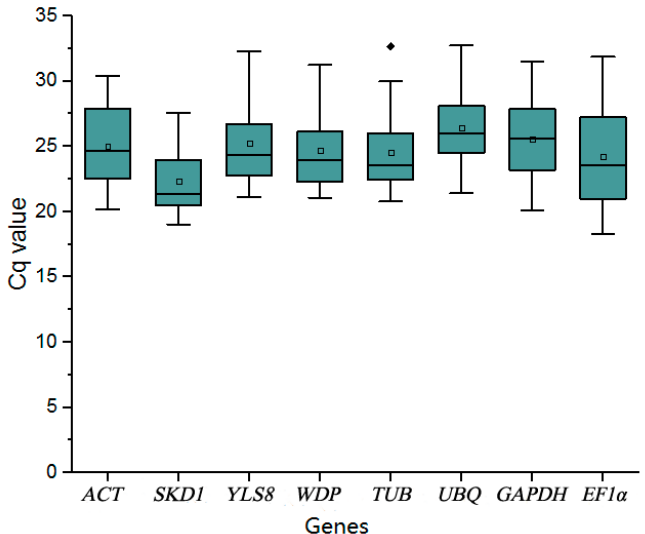
Figure 6. RT-qPCR Cq values of the candidate reference genes in pear leaves. Candidate reference genes were analyzed in all conditions. Boxes indicate the 25th and 75th percentiles. Lines across boxes represent the median values. Circles represent the mean values, and the spot represents the outlier. Whiskers represent the maximum and minimum values.